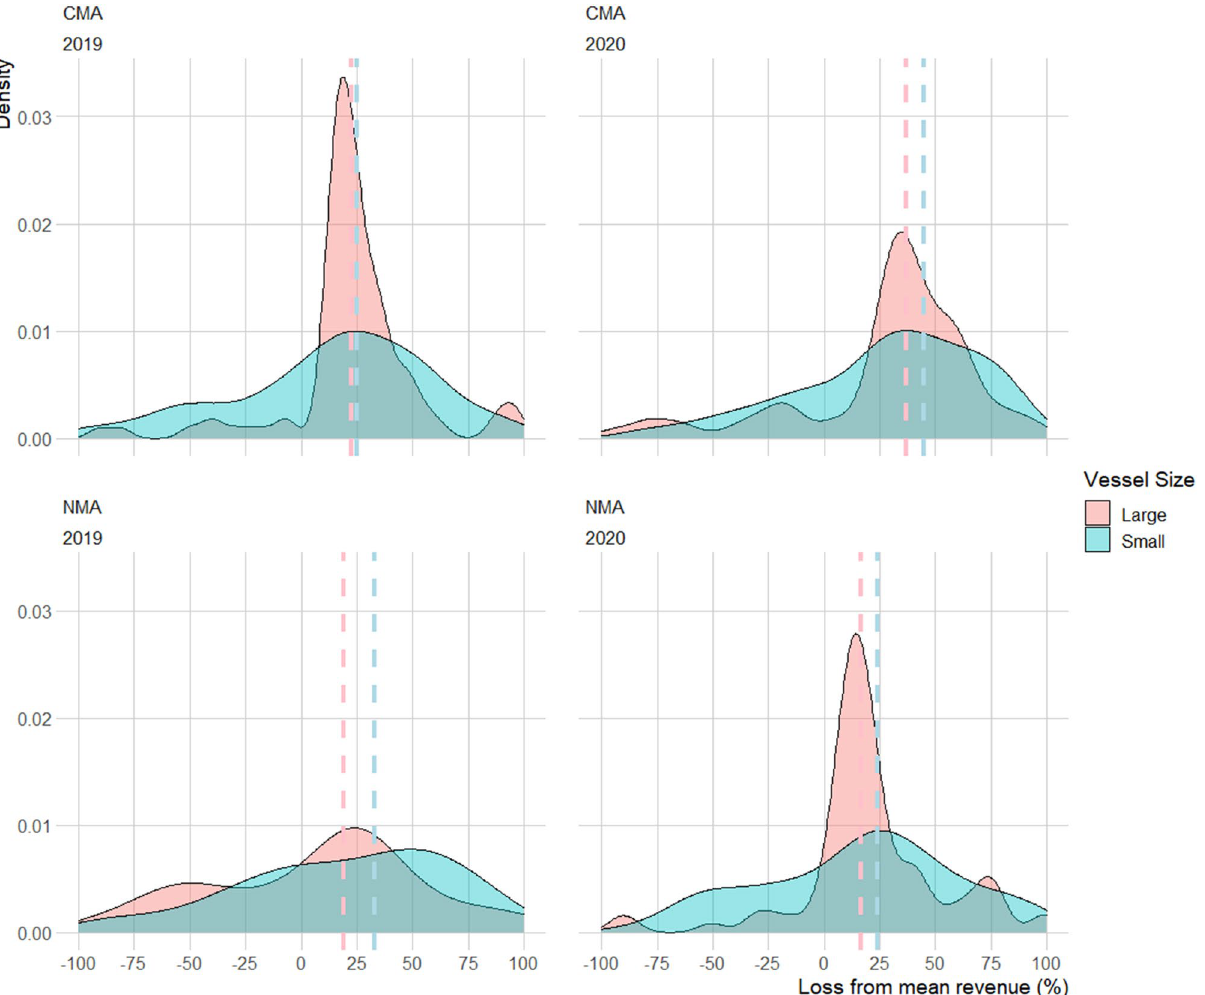
Figure 4. Density plots of estimated percentage ex-vessel revenue loss as a proportion of a vessels mean annual revenue (2011–2018) by small and large vessels in the Northern and Central Management Areas for the 2019 and 2020 fishing seasons. Median revenue losses are shown with dashed lines. Predicted revenues from within the 25th to 75th percentile are included. Negative numbers on the X axis indicate no revenue loss. The X axis has been restricted to between – 100 and 100 for plotting